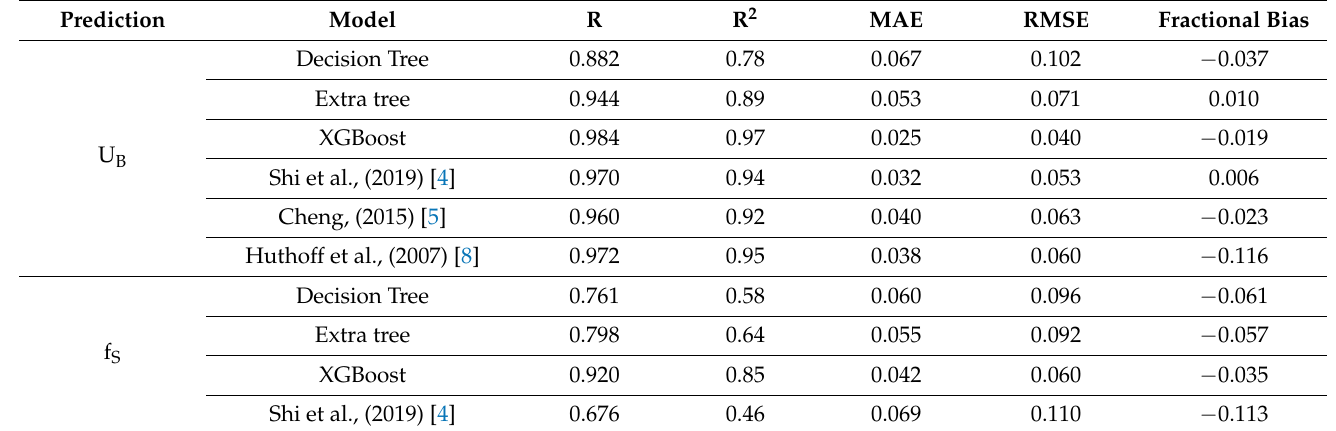
Figure 6. Comparison of validation accuracies of predicted U B : ( a ) decision tree regressor; ( b ) extra tree regressor; ( c ) XGBoost regressor; ( d ) Shi et al. [4]; ( e ) Cheng [5]; ( f ) Huthoff et al. [8]. Table 2. Comparison of uncertainty indices for validation